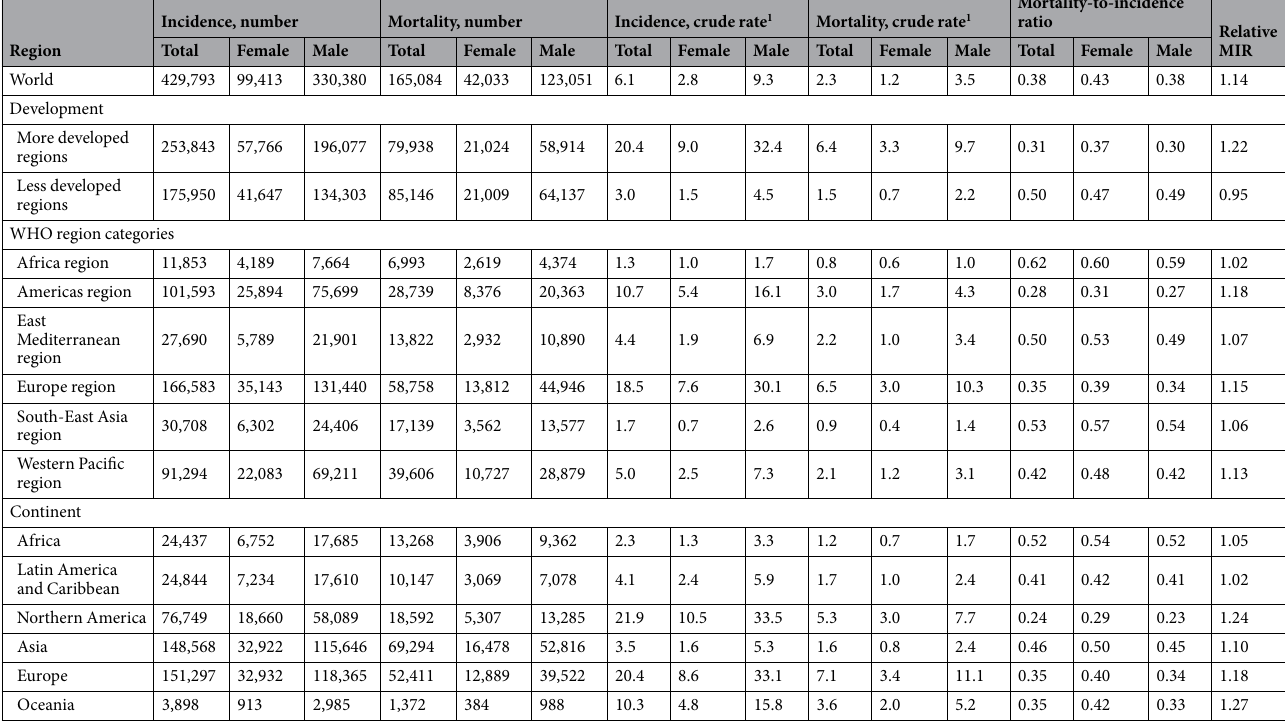
Table 1. Summary of bladder cancer crude rate of incidence, mortality, and mortality-to-incidence ratio of 184 countries according to regions. 1 Crude rates were defined as the rates per